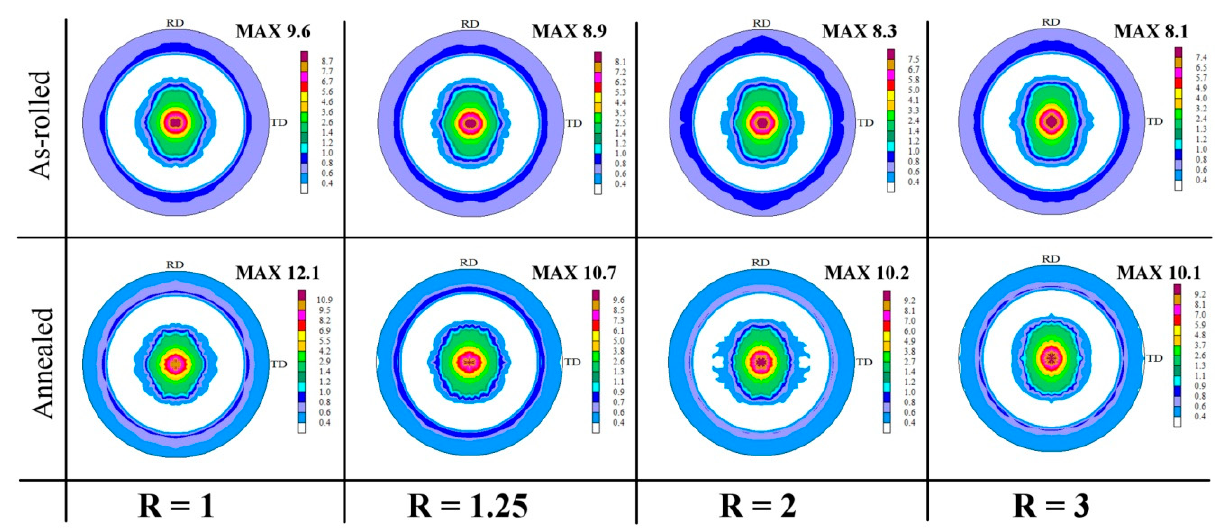
Figure 6. The (0002) pole figures of the as-rolled and annealed Mg-6Sn sheets processed with different speed ratio (R) obtained from XRD measurements on the RD-TD plane.